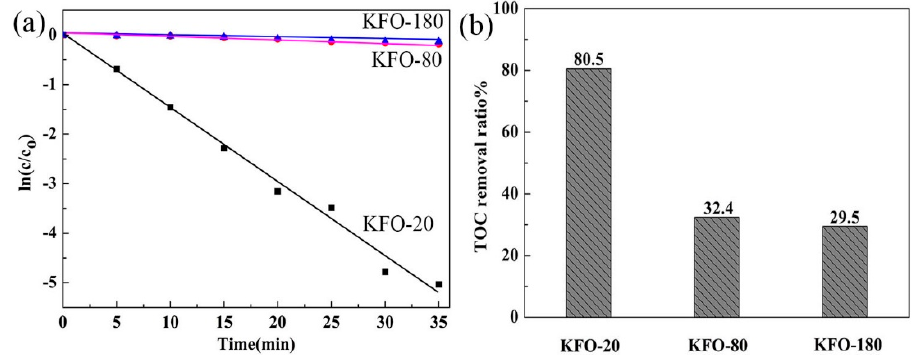
Figure 5. ( a ) Pseudo-first-order kinetics degradation of MB; ( b ) total organic carbon (TOC) removal of MB in presence of di ff erently sized KFOs. Reaction conditions: MB concentration, 20 mg / L; KFO mass, 30 mg; H 2 O 2 , 10 mM; reaction time, 35 min. Table 2. KFO specific surface area S (m 2 / g) and rate constant k (min − 1 ). S (m 2 /